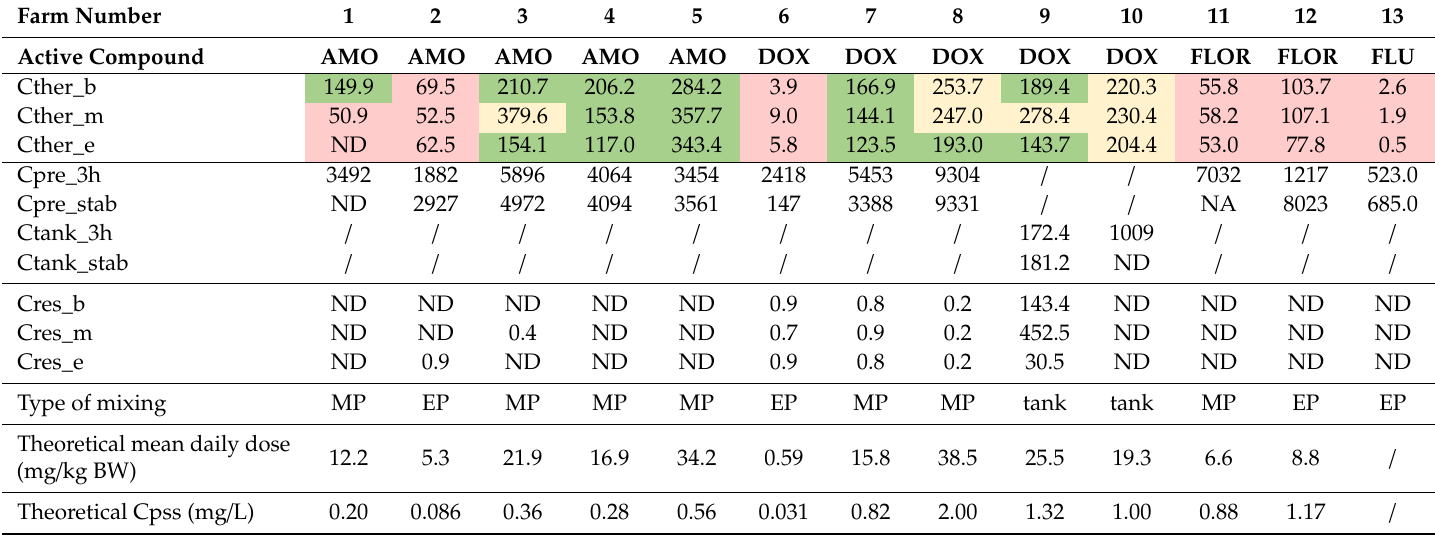
Table 2. Mean concentrations of amoxicillin (AMO), doxycycline (DOX), florfenicol (FLOR), and flubendazole (FLU) in the medicated drinking water samples (duplicate measurements), presented as µ g / mL. The samples taken during treatment were collected at 3 h after the start of the treatment and at the beginning (Cther_b), middle (Cther_m), and end (Cther_e) of the drinking water pipeline. Both the pre-solution (in case a dosing pump was used), and the drinking water tank were sampled after 3 h (Cpre_3h / Ctank_3h) and just before the pre-solution / tank was finished or just before a new batch of pre-solution / tank was prepared to determine its stability (Cpre_stab / Ctank_stab). Samples were also taken at 2 days after the end of the treatment to measure the residues at the beginning (Cres_b), middle (Cres_m), and end (Cres_e) of the drinking water pipeline. Values shown in green are within the therapeutic concentration range for that active compound (106–368 µ g / mL AMO; 82–199 µ g / mL DOX; 134–184 µ g / mL FLOR; 134–340 µ g / mL FLU). Values in red are below the therapeutic concentration range, while values higher than the therapeutic concentration range are shown in yellow. Values below the detection limit are presented as ND (not detected). The type of mixing the medicinal product in the water is also shown. The theoretical mean daily dose of each antimicrobial drug during treatment (mg / kg BW) is presented at the bottom, and is based on the average bodyweight (BW) and average daily water intake per farm. The corresponding theoretical plasma concentration at steady state (Cpss, mg / L) is also